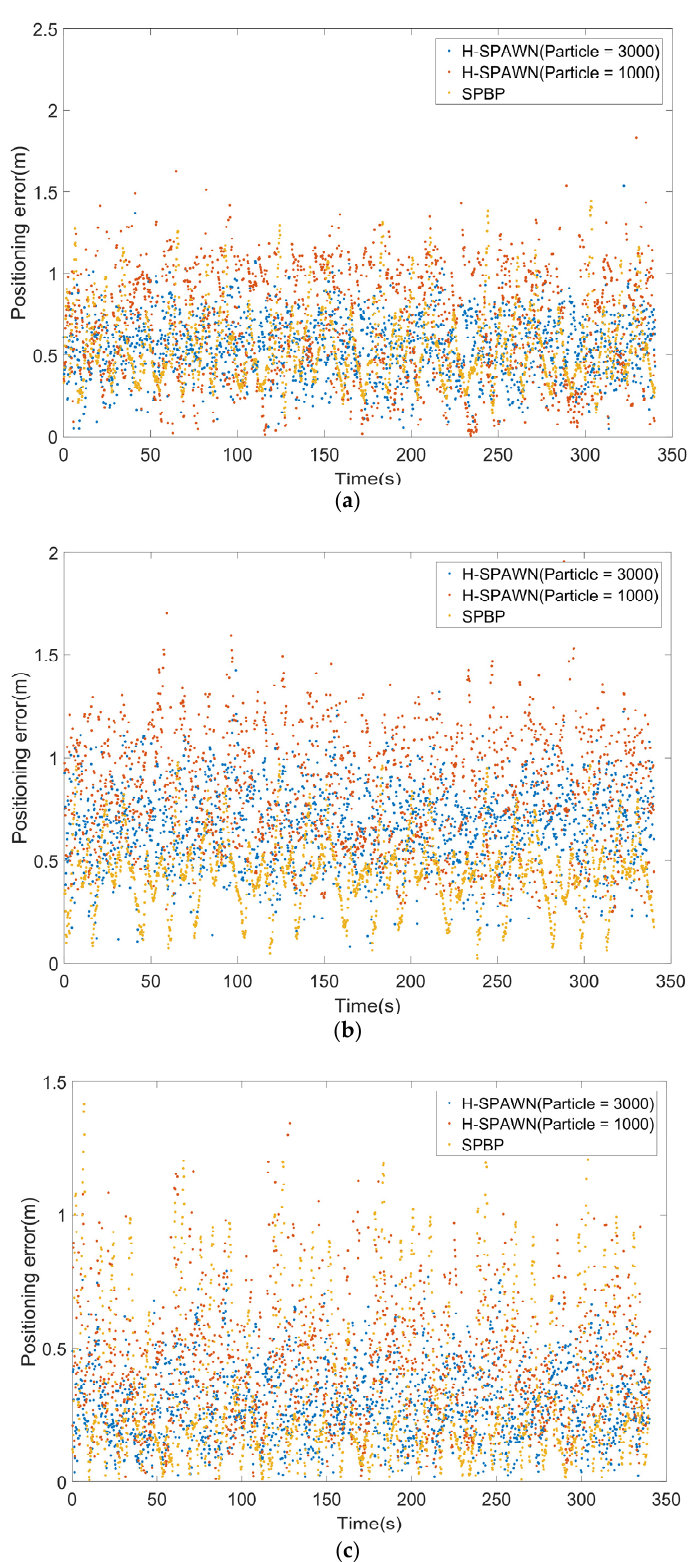
Figure 14. Positioning error comparisons: H-SPAWN (particle number = 3000), H-SPAWN (particle number = 1000), SPBP. ( a ) Positioning error of UAV 3. ( b ) Positioning error of UAV 4. ( c ) Positioning error of UAV